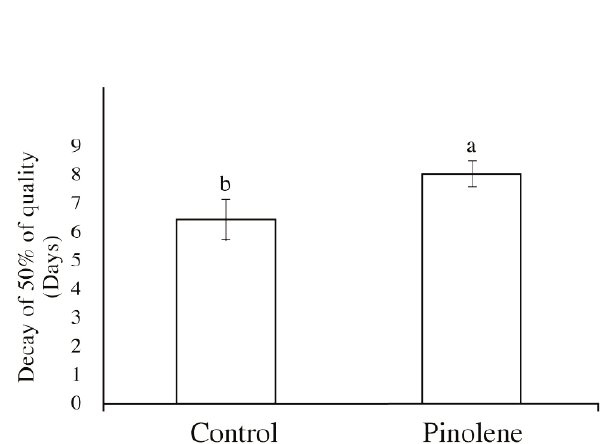
Fig. 2 - Effect of exogenous β-aminobutyric acid (BABA) on water flux (A) and water consumptions per leaf area (B) of rose cut stems during storage. Vertical bars indicate ± SE of means.